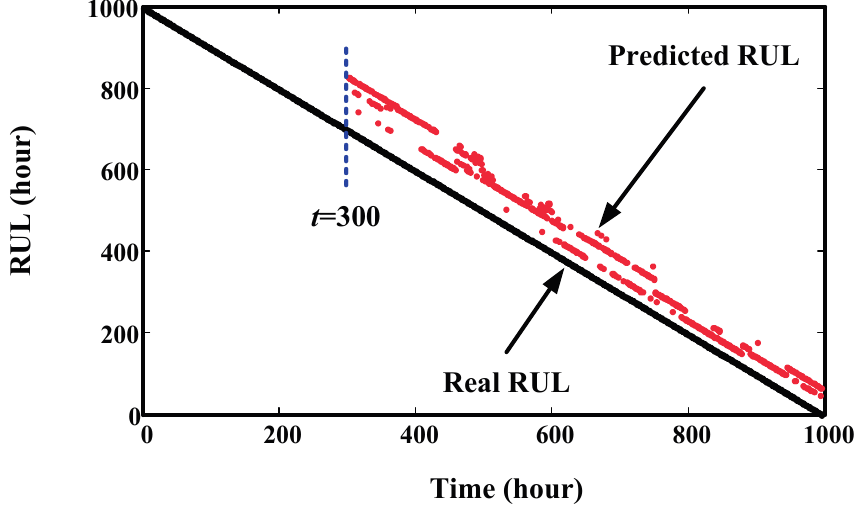
Figure 13. Prediction results of Component 1 at different time